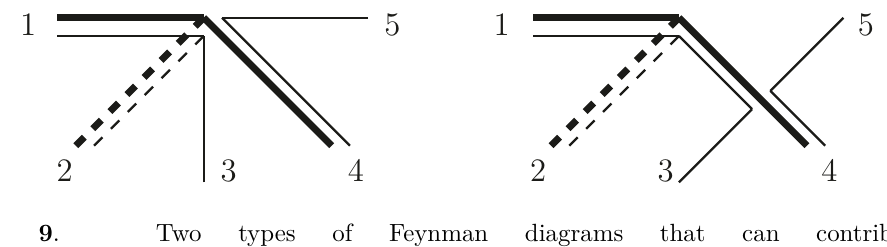
Figure 9 . Two types of Feynman diagrams that can contribute to (1 , 2 , 3 | 4 , 5 || 1 ψ , 2 φ , 4 ψ ) . The solid lines represent fundamental indices, while the M NLSM + φ + ψ 5 dashed lines represent adjoint indices. The thin lines are for the SO ( N ) flavor group of the NGB’s, while the thick lines are for the other flavor group ˜ H carried by φ and ψ . Although the contact term on the left vanishes, the diagram on the right still contribute, so that the amplitude is non-zero. The 4-pt vertex in the diagram on the right is given by eq.